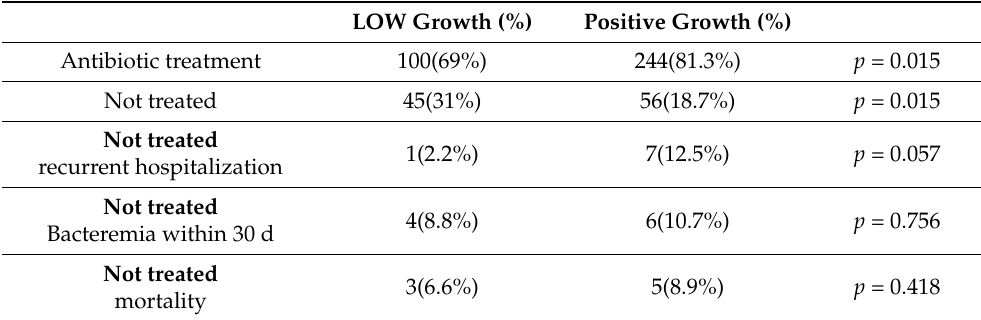
Table 4. Comparison of the antibiotic treatment rates on low-growth vs. positive-growth group and hard outcome of untreated patients in both groups.